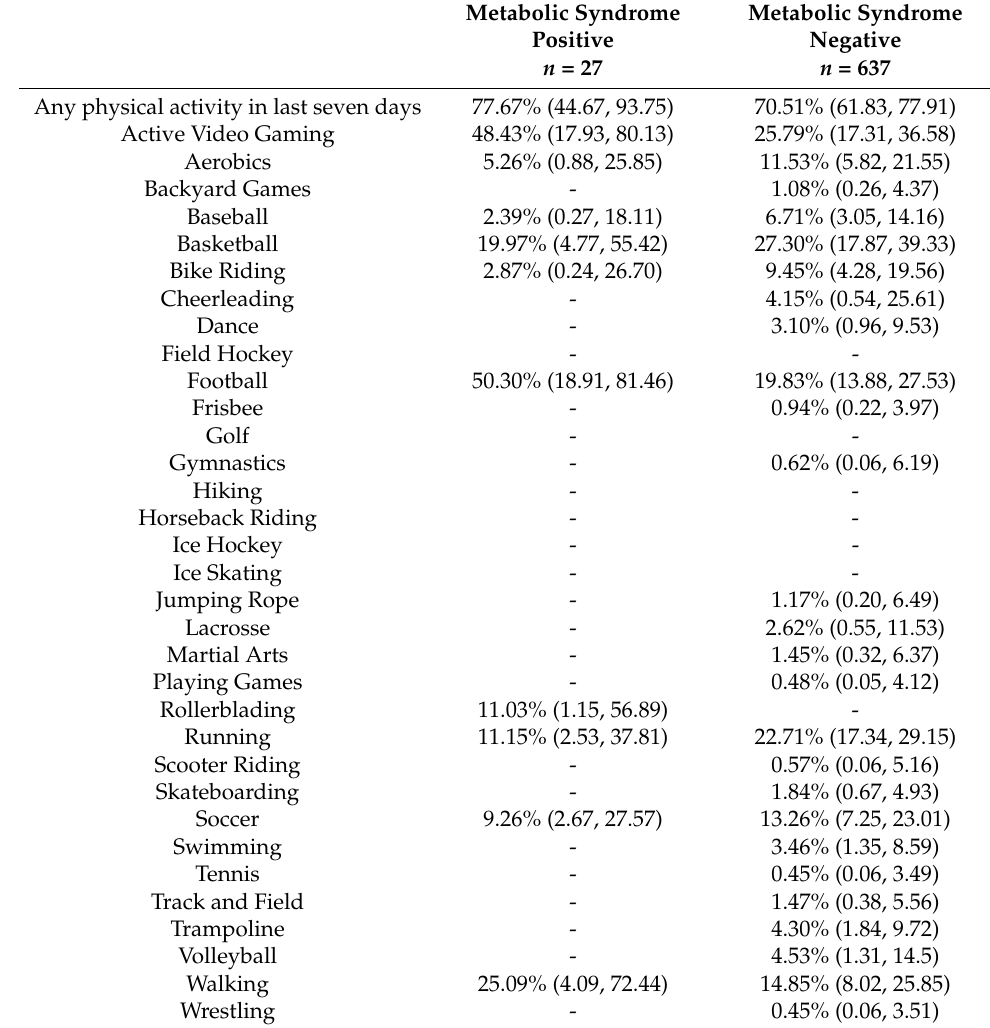
Table 2. The proportion of the type of physical activity